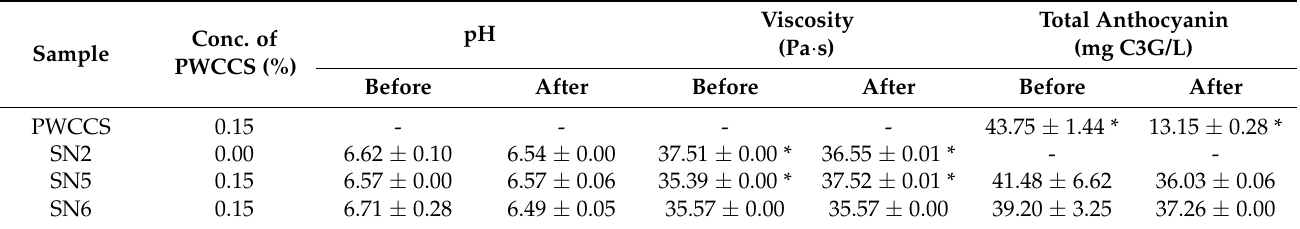
Table 4. The stability tests for determination of pH properties, viscosity (Pa · s), and anthocyanin content remaining comparison before and after heating-cooling storage